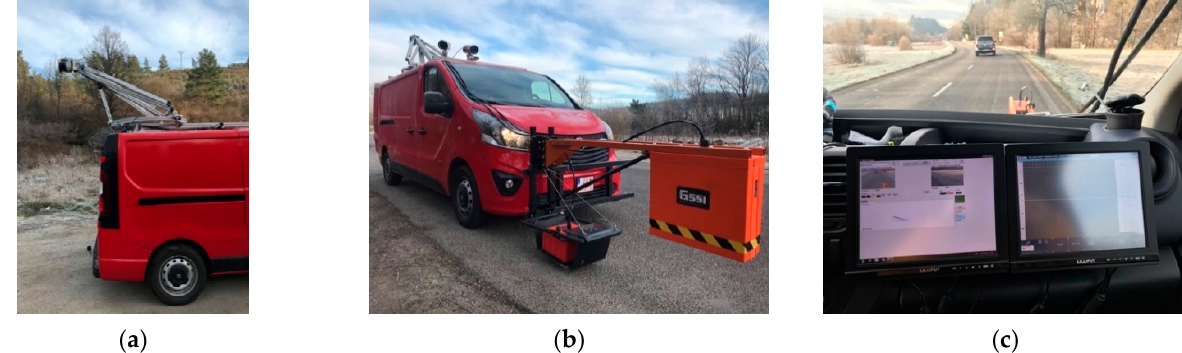
Figure 3. Laser scanner ( a ); Ground-penetrating radar and video inspection ( b ); Diagnostic vehicle-interior ( c ).